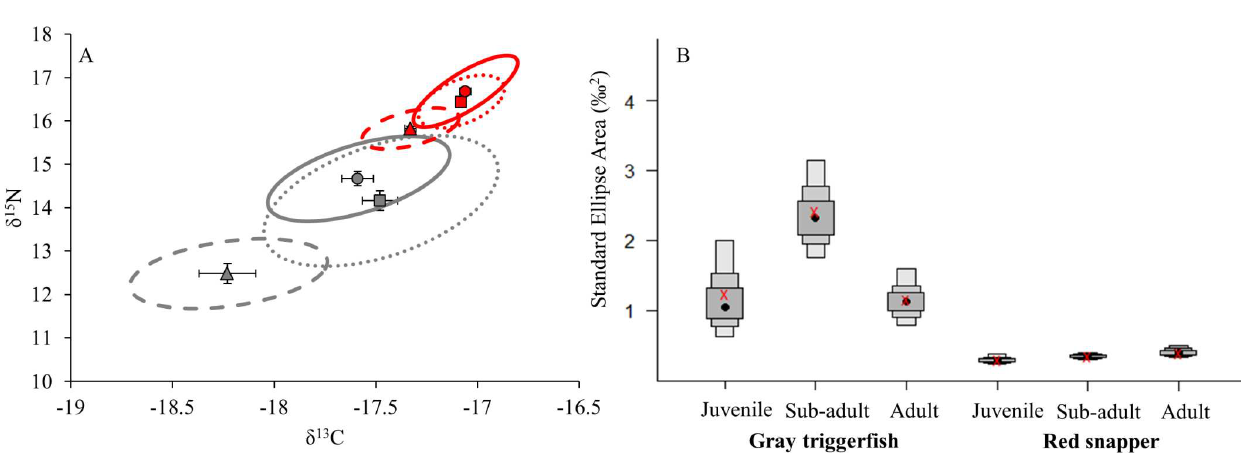
No significant overlap was observed among isotopic niches for either gray triggerfish or red snapper between the east and central (gray triggerfish = 0.136, red snapper = 0.002), east and west (gray triggerfish = 0.043, red snapper = 0.008), and central and west (gray